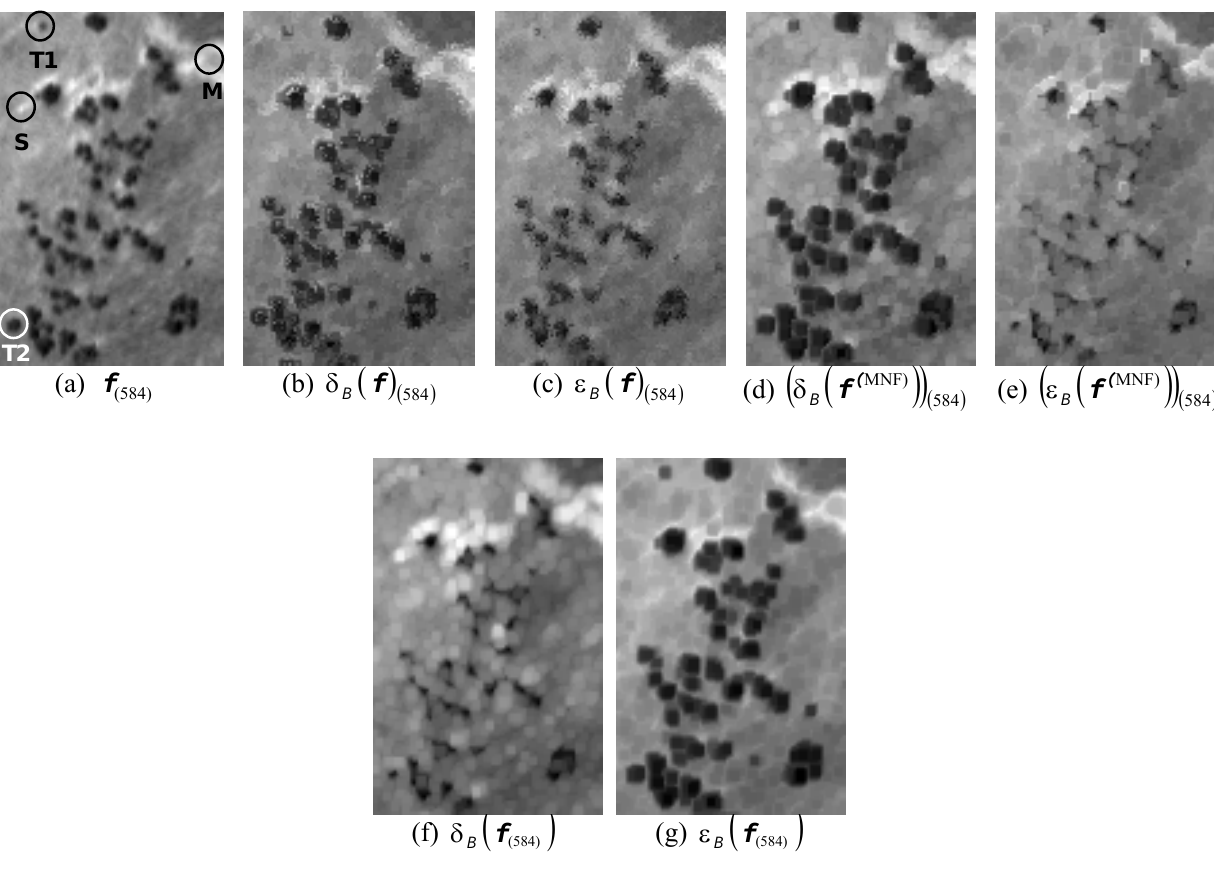
r ), pasture ( r ) and cork-oak tree ( r ). (b) 1 2 3